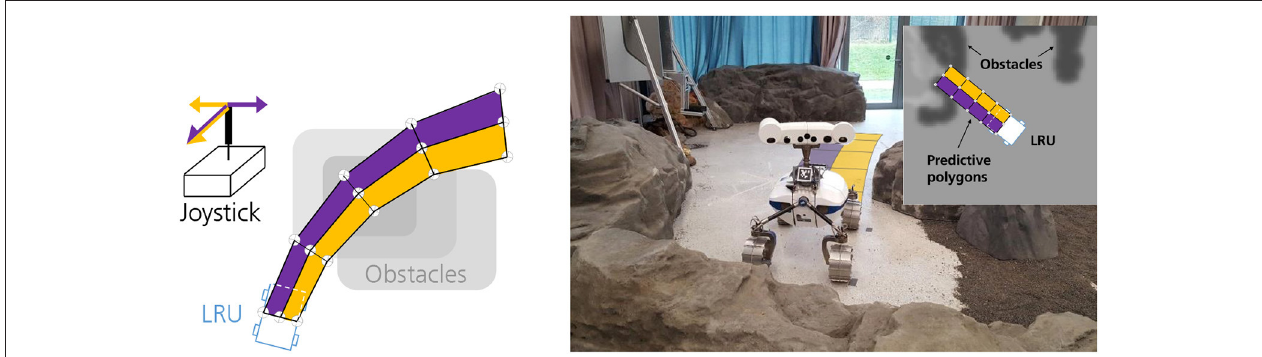
FIGURE 13 | (Left) Schematic showing the generation of fictitious forces by polygons overlapping with obstacle in the danger map [ © 2020 IEEE. Reprinted, with permission, from Panzirsch et al. (2018b)]. (Top Right) Screenshot of the user interface. (Bottom Right) LRU with augmented polygons in the experimental environment [ © Sierotowicz et al. (2020), CC BY 4.0, images have been modified].